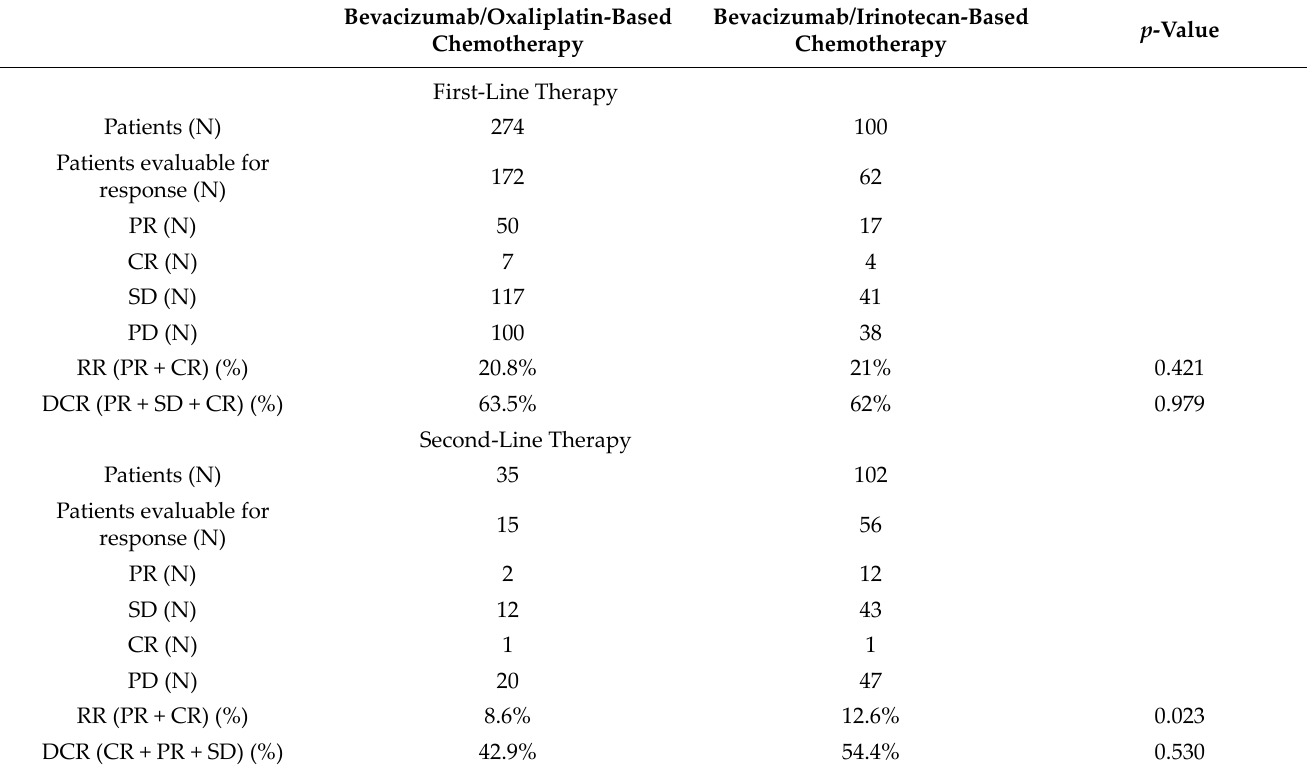
Table 3. Disease control rate and rate of response for patients with mCRC treated with bevacizumab and chemotherapy in the first and second lines.